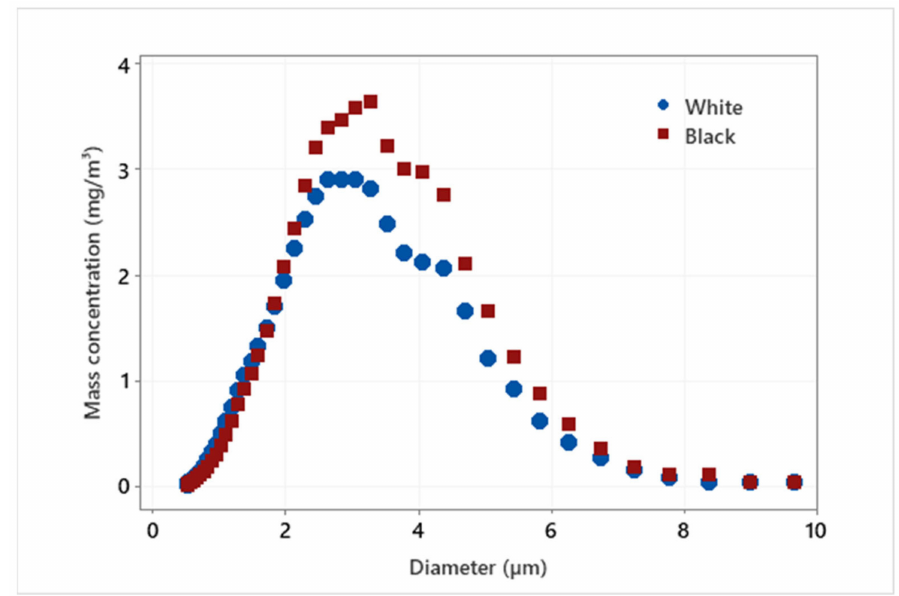
Figure 7. Particle size distribution of FP by mass concentration when grinding a white versus a black granite edge (Vs = 3500 rpm; f = 1000 mm/min; grit